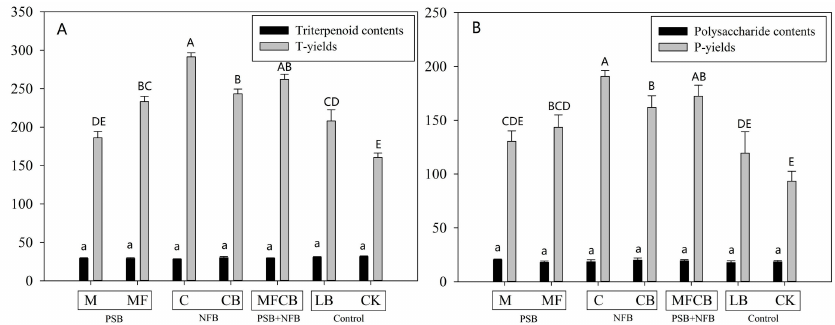
Figure 5. Concentrations (mg · g − 1 ) and yields (mg · plant − 1 ) of total triterpenoid ( A ) and water-soluble polysaccharide ( B ). Di ff erent lowercase / capital letters denote significant di ff erences of concentrations / yields among treatments at p <